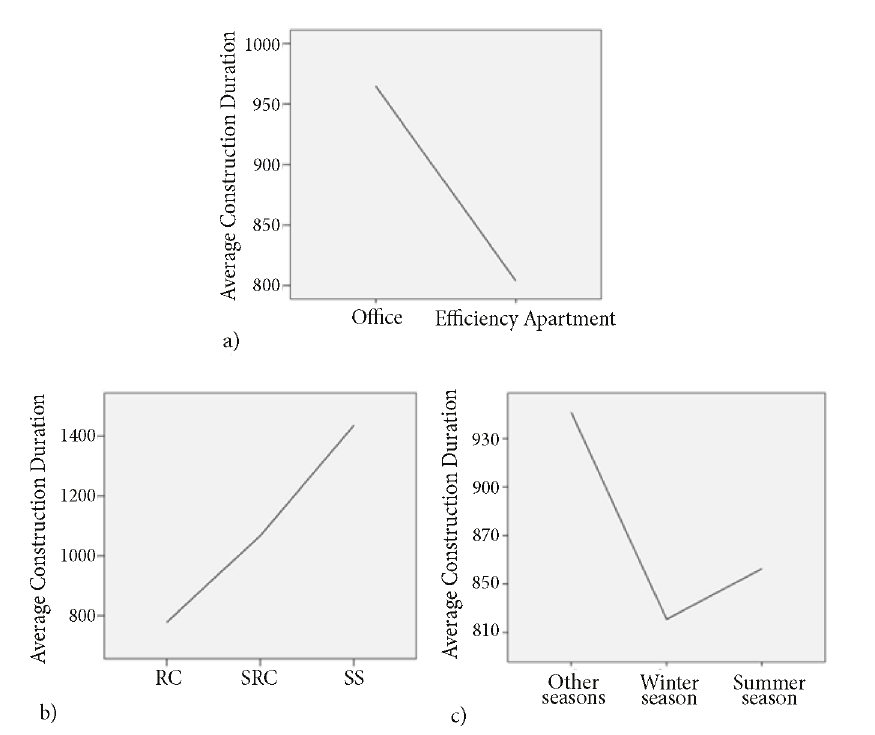
Figure 4. Trend of average construction duration based on the analysis data: a – average construction duration trend based on facility type; b – average construction duration trend based on structural form;